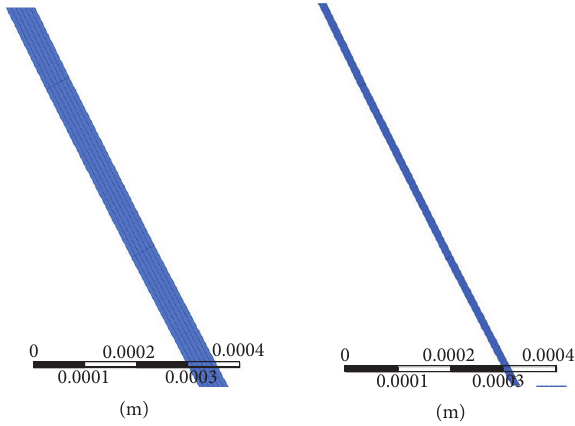
Figure 5: Grid deformation of the plain gas film. Figure 6: Grid deformation of the herringbone groove gas